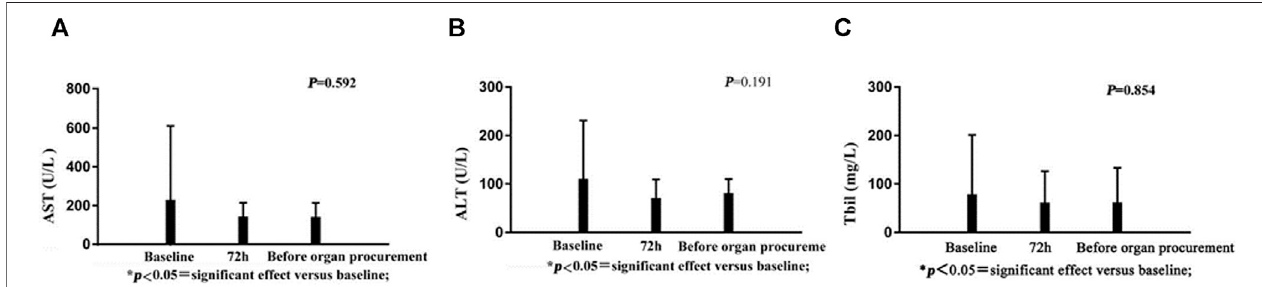
FIGURE 2 | AST, ALT and Tbil during infusion of norepinephrine or terlipressin.